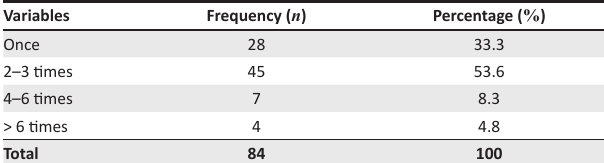
TABLE 1: Frequency of missed